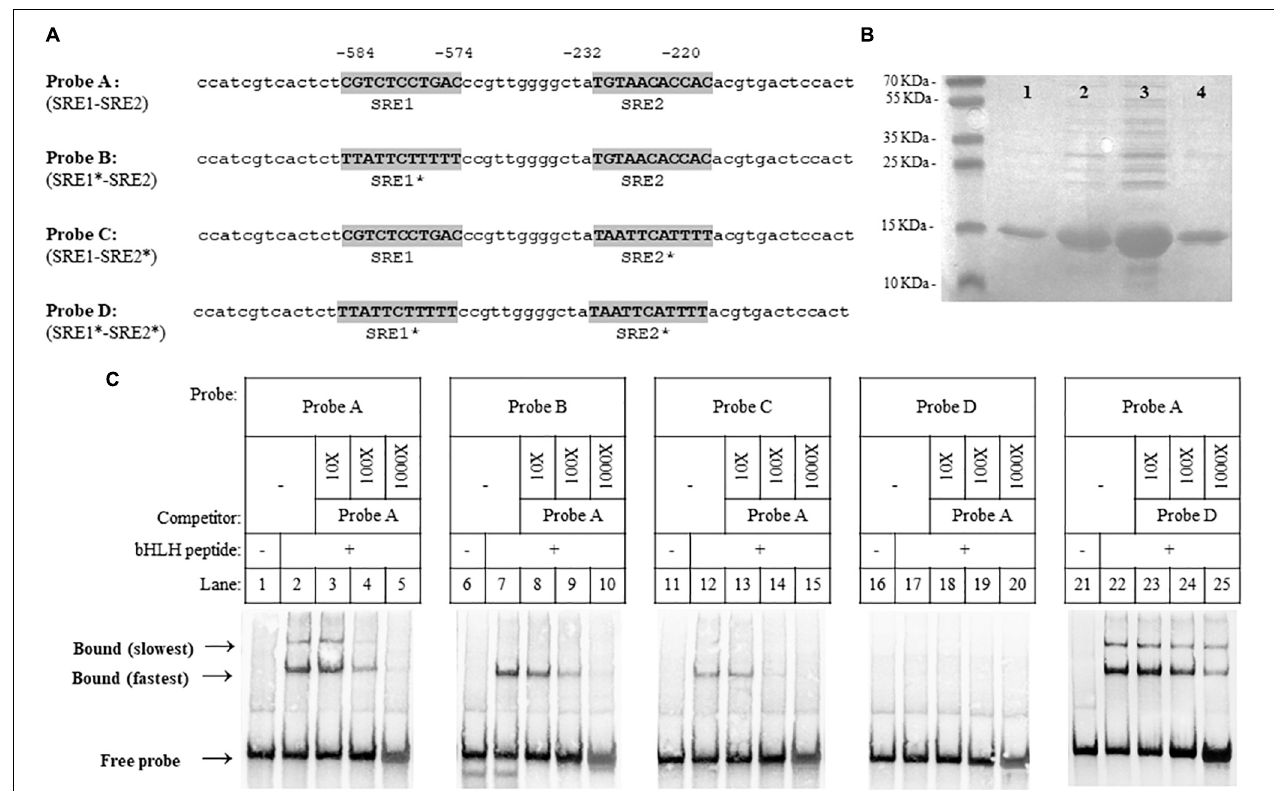
FIGURE 3 | Xanthophyllomyces dendrorhous Sre1 binding to DNA. Sre1 binding to DNA was evaluated by employing DNA fragments of 60 bp in length, which were designed from the X. dendrorhous HMGS gene promoter containing 2 predicted SRE elements. (A) Probe sequences are shown: wild-type (probe A) and mutants (probes B to D). The two potential SRE elements (SRE1 and SRE2) are highlighted in gray and the ( ∗ ) after SRE1 or SRE2 indicates if the corresponding SRE element is mutated. Numeration above the sequences is relative to the HMGS gene translation initiation ATG codon. (B) SDS-polyacrylamide gel electrophoresis of different fractions of purified recombinant Sre1 protein (residues 349 – 477) containing the bHLH DNA-binding motif of X. dendrorhous Sre1, 4 fractions are shown as an example. Gel was stained with Coomassie blue and fraction 3 (lane 3) was used in the EMSA assays. (C) EMSA assays. Purified recombinant bHLH DNA-binding Sre1 protein was mixed with the indicated biotinylated DNA probes: probe A (lanes 2–5 and 22–25), probe B (lanes 7–10), probe C (lanes 12–15) and probe D (lanes 17–20), including the corresponding controls without the bHLH protein (lanes 1, 6, 11, 16, and 21). Assays were performed in the absence (lanes 2, 7, 12, 17,